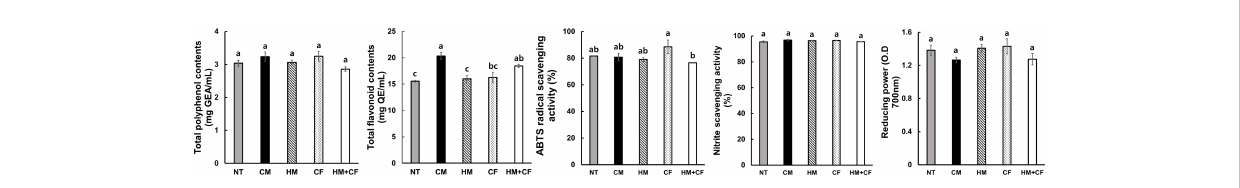
FIGURE 3 Total polyphenol and fl avonoid contents, ABTS radical and nitrite scavenging activities, and reducing power activities after different fertilizer supplies (NT, non-treatment; CM, commercial manure; HM, Hanwoo manure; CF, chemical fertilizer; HM+CF, combined use of Hanwoo manure and chemical fertilizer). The values are the mean ± standard deviation (n = 3). The lowercase letters represent the signi fi cant differences (p < 0.05) between groups using the Duncan